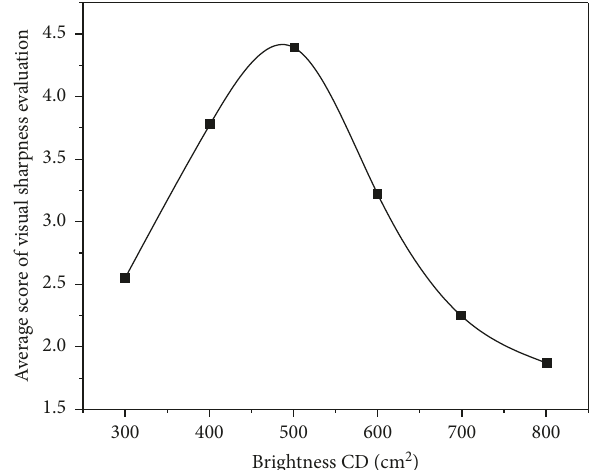
Figure 1: Analysis of average score and brightness change trend of visual acuity